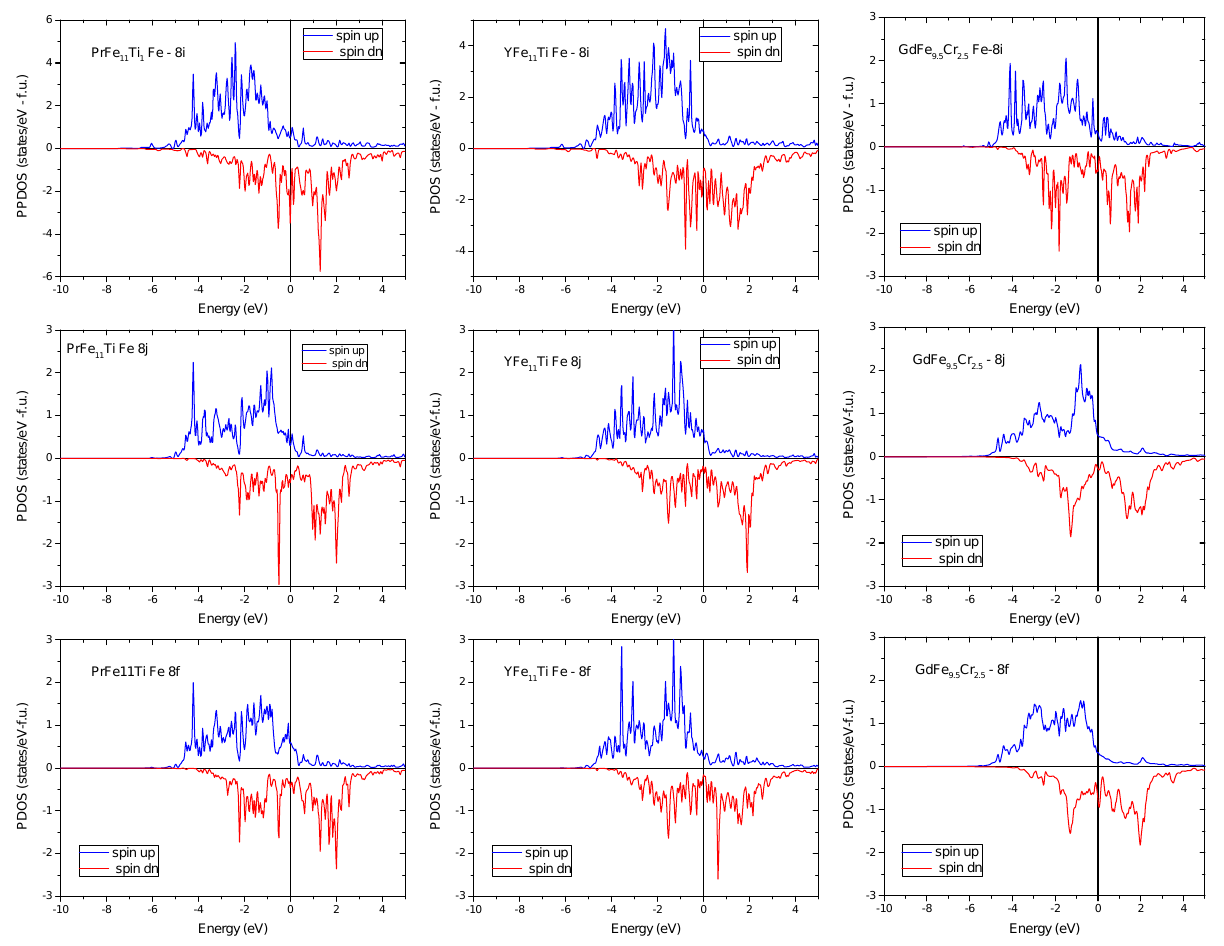
Figure 10. Partial density of states for Fe-8 i , Fe 8 j and Fe-8 f calculated for ( left ) PrFe 11 Ti, ( middle ) YFe 11 Ti and ( right ) GdFe 9.5 Cr 2.5 . The origin of the energy is located at Fermi energy (black vertical